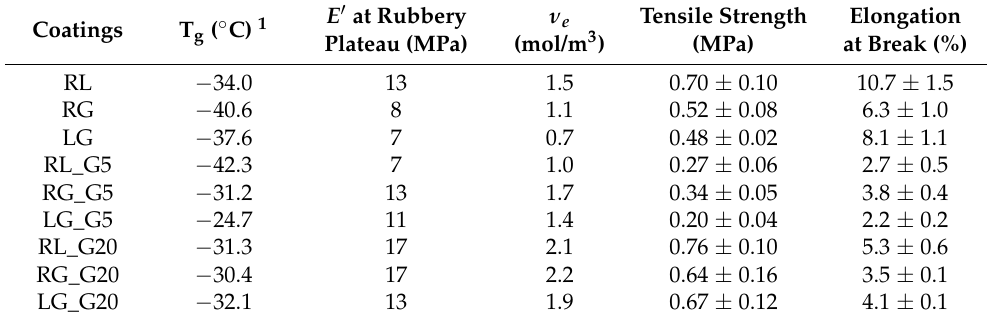
Figure 4. DMA plots for photopolymerized AVO coating films: ( a ) storage modulus and tan δ ; ( b ) loss modulus. Table 3. Mechanical properties of